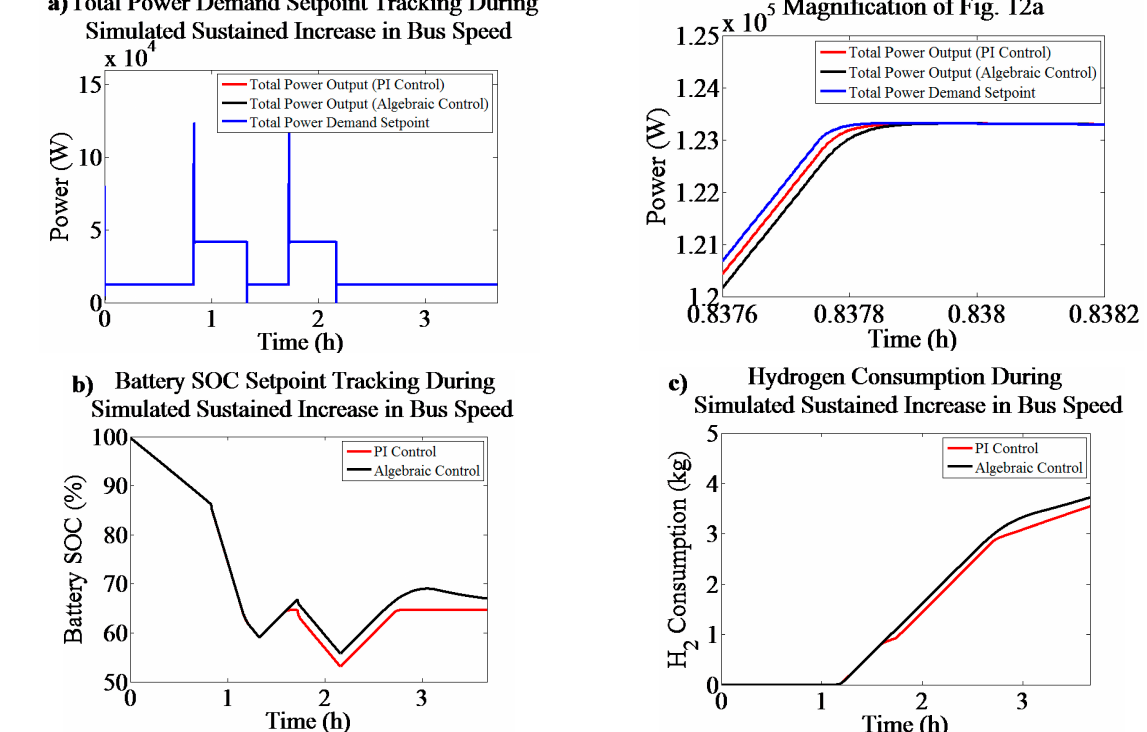
Figure 12. Simulation results of bus operation under sustained increases in bus speed: ( a ) total power demand set point tracking, along with a magnified plot illustrating details; ( b ) battery SOC set point tracking; and ( c ) hydrogen consumption profile. The bus is able